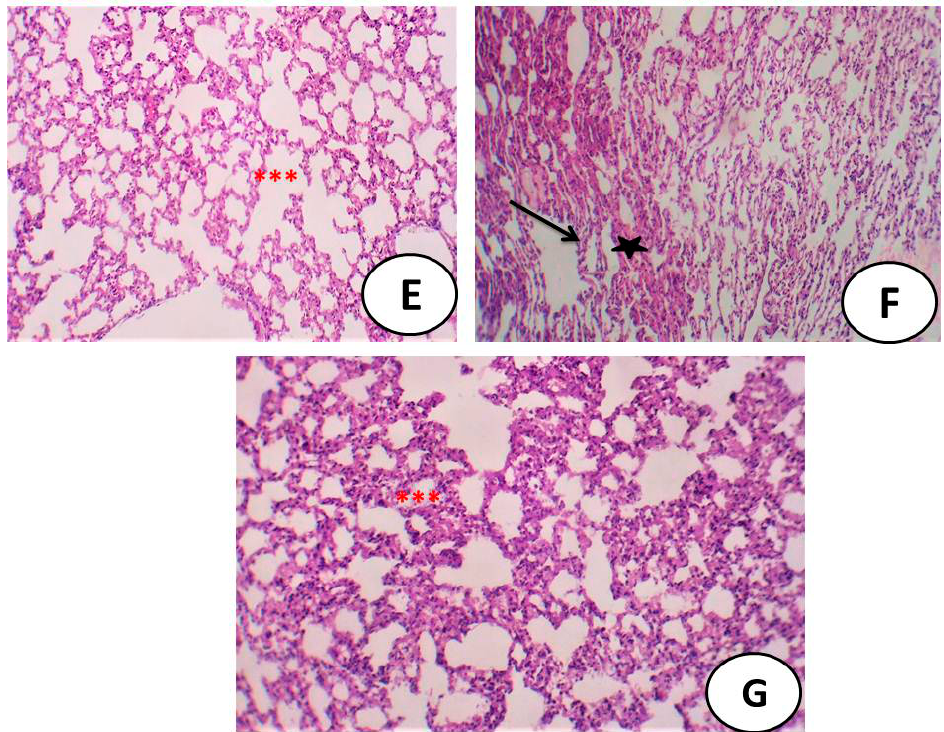
Figure 9. ( A ) Control group: photomicrograph of a cross-section of the pulmonary tissues, showing normal alveoli (black star) and interalveolar septa (arrow) (H&E × 400). ( B ) Photomicrograph of the lungs of male mice after exposure to the aerosol of an E-cig, showing the loss of the normal architecture of the lung thickening of alveolar wall and marked interstitial inflammatory infiltrate (H&E × 400). ( C ) Photomicrograph of the pulmonary tissues of PRD/Zn showing normal alveoli with interalveolar septa (***). ( D ) Photomicrograph of a cross-section of the pulmonary tissues of ART showing normal alveoli with interalveolar septa (***). ( E ) Cross-section of the lungs of male mice after the administration of the aerosol of an E-cig, followed by PRD/Zn, showing mild thickening of some alveoli (arrow), while other areas showed mild inflammatory infiltrate (star) (H&E × 200). ( F ) Photomicrograph of the lungs of male mice after administration of the aerosol of an E-cig, followed by ART, showing mild thickening of some alveoli (arrow) while other areas showed mild inflammatory infiltrate (star) (H&E × 200). ( G ) Photomicrograph of the lungs of male mice after the administration of the aerosol of an E-cig, followed by both PRD/Zn and ART, showing a high recovery of normal pulmonary tissues with partial subsiding of inflammation (***), with a mild thickness of alveoli (H&E ×